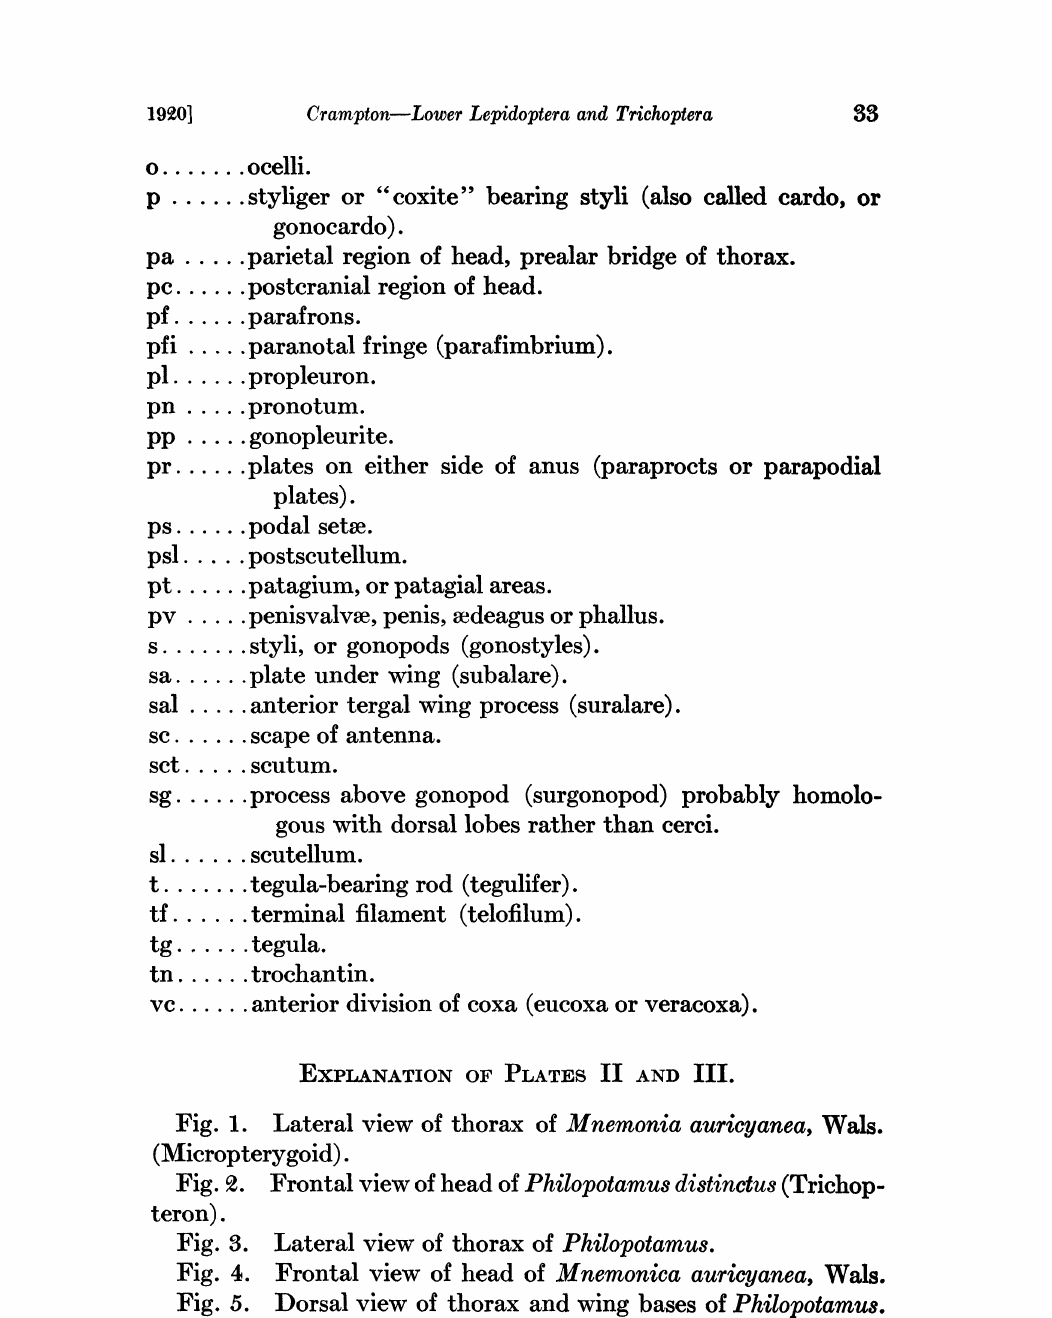
. Fig. 1. Lateral view of thorax of Mnemonia auricyanea, Wals. (Micropterygoid). :Frontal view of head of Philopotamus distinctus (Trichop- Fig. teron). Fig. 3. Lateral view of thorax of Philopotamus. Fig. 4. Frontal view of head of Mnemonica auricyanea, Wals. Fig. 5. Dorsal view of thorax and wing bases of